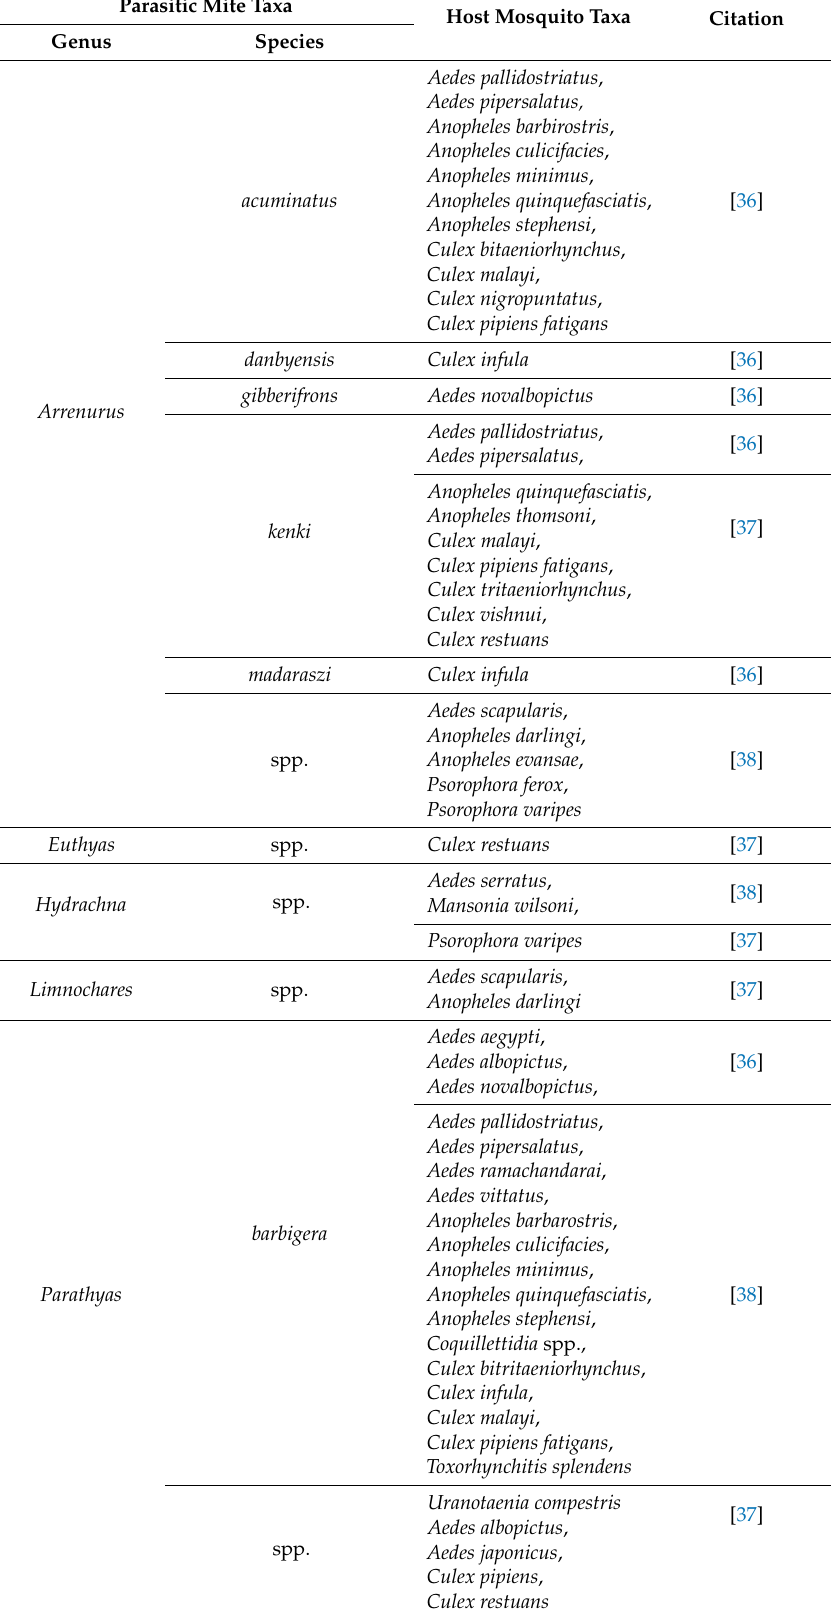
Table 3. List of water mite–mosquito associations since Simmons and Hutchinson